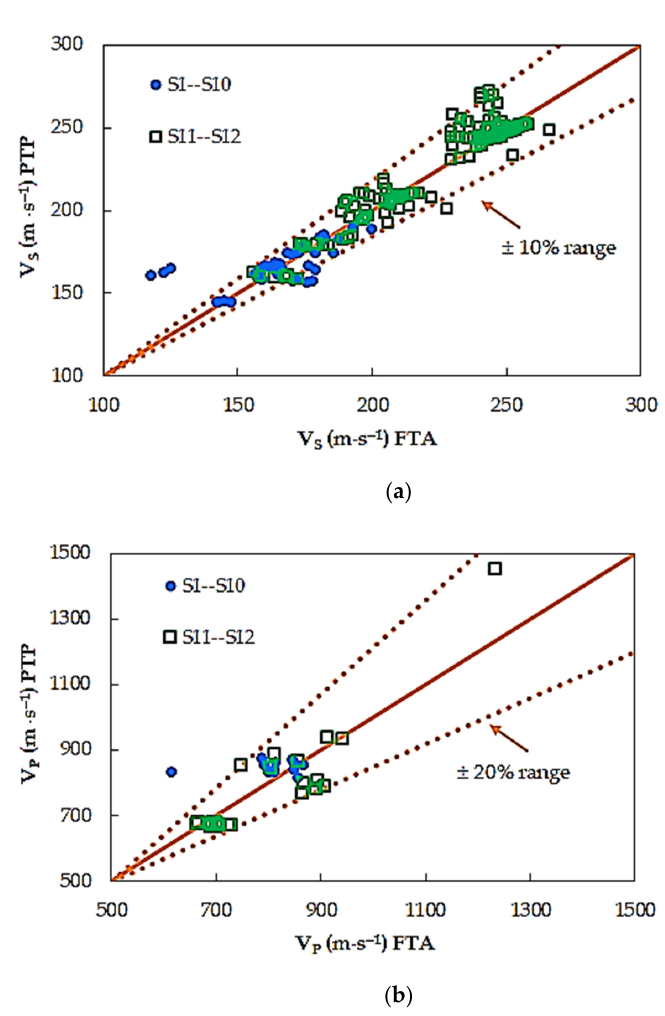
Figure 5. Comparison of ( a ) S-wave and ( b ) P-wave velocities, between the first time of arrival (FTA) and peak-to-peak (PTP) methods of signal analysis.